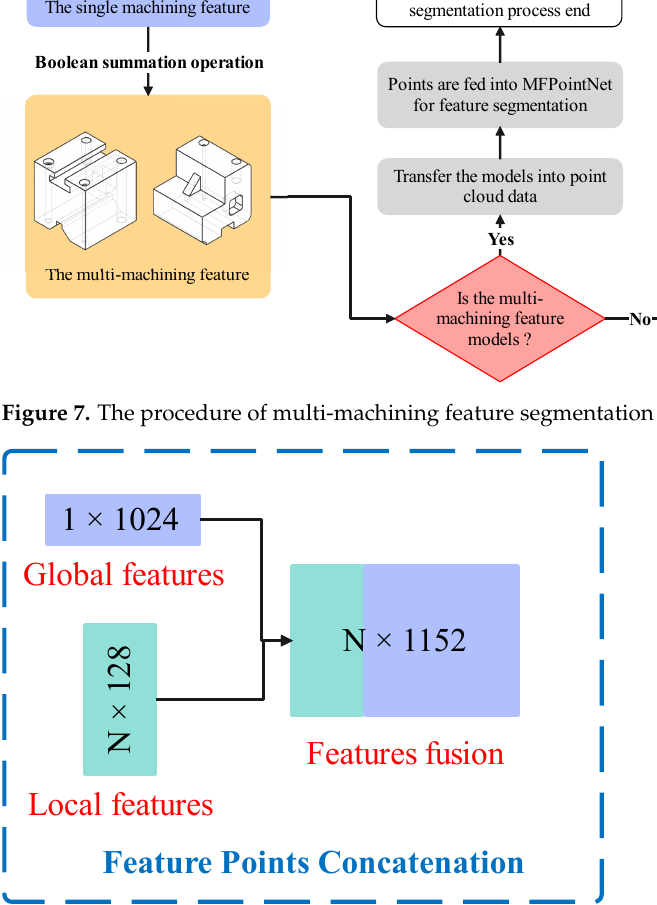
Figure 8. The process of machining feature point